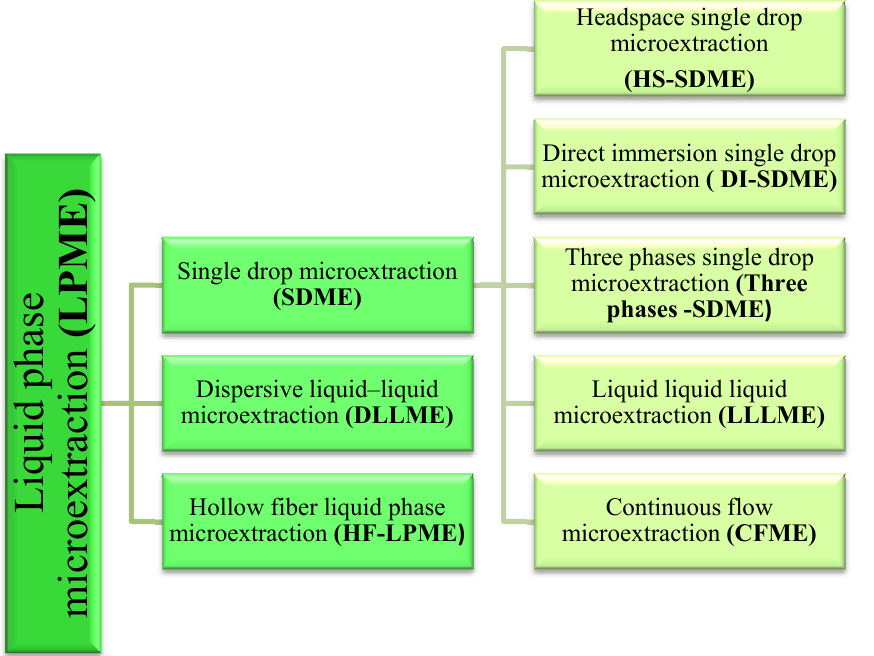
Figure 2. Classification of various approaches in liquid-phase